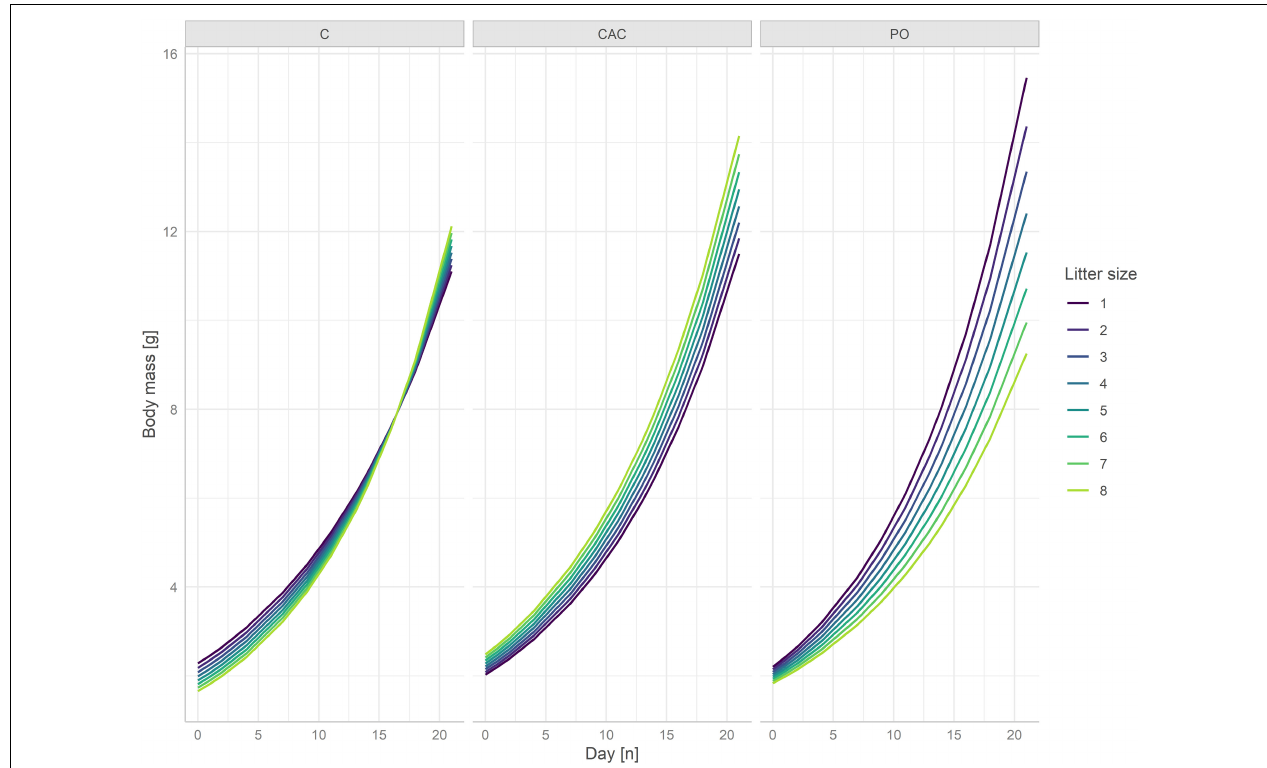
FIGURE 1 | Individual pup mass per day and litter size. Different treatments are in facets.